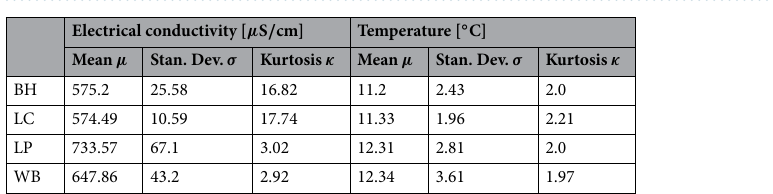
Figure 4. Normalised histograms of ( a ) electrical conductivity; and ( b ) temperature for all sensor locations. Note the log-scale on the y-axis, which highlights the heavy tails in BH.